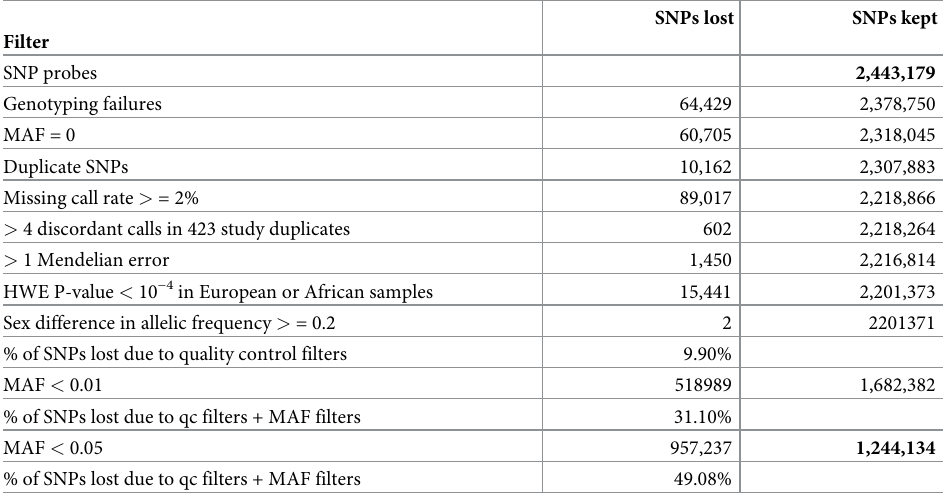
Table 3. Summary of quality control steps with the number of SNPs lost and kept for each